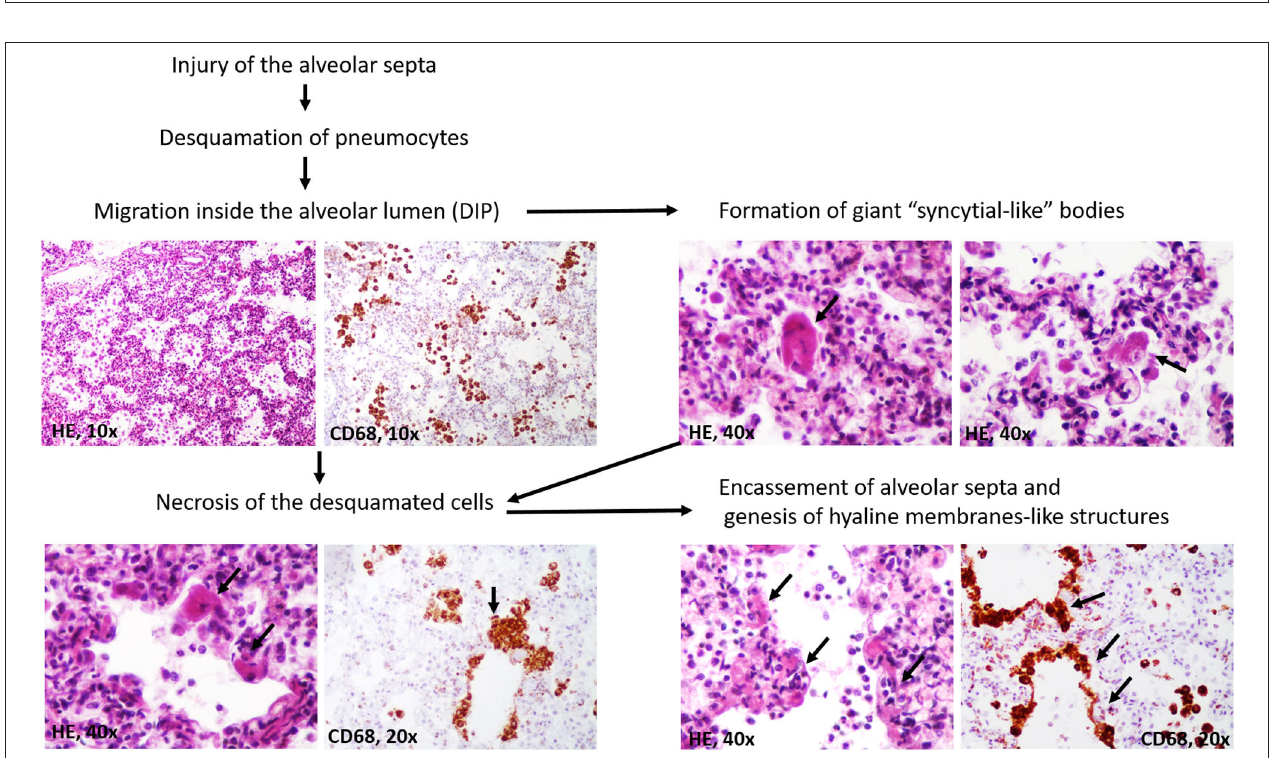
FIGURE 2 | Microscopic and immunohistochemical features of desquamative interstitial pneumonia: (A) hemorrhages and thrombi (arrow); (B) bronchiolar damage; (C) desquamated pneumocytes, with syncytial-like bodies; (D) scanty T-cells; (E) necrosis of the desquamated cells, with genesis of membranes; (F) Encasement of alveolar septa by cytokeratin-positive membranes; (G) Positivity of the desquamated cells for cytokeratin; (H) IgA positivity in the desquamated cells.